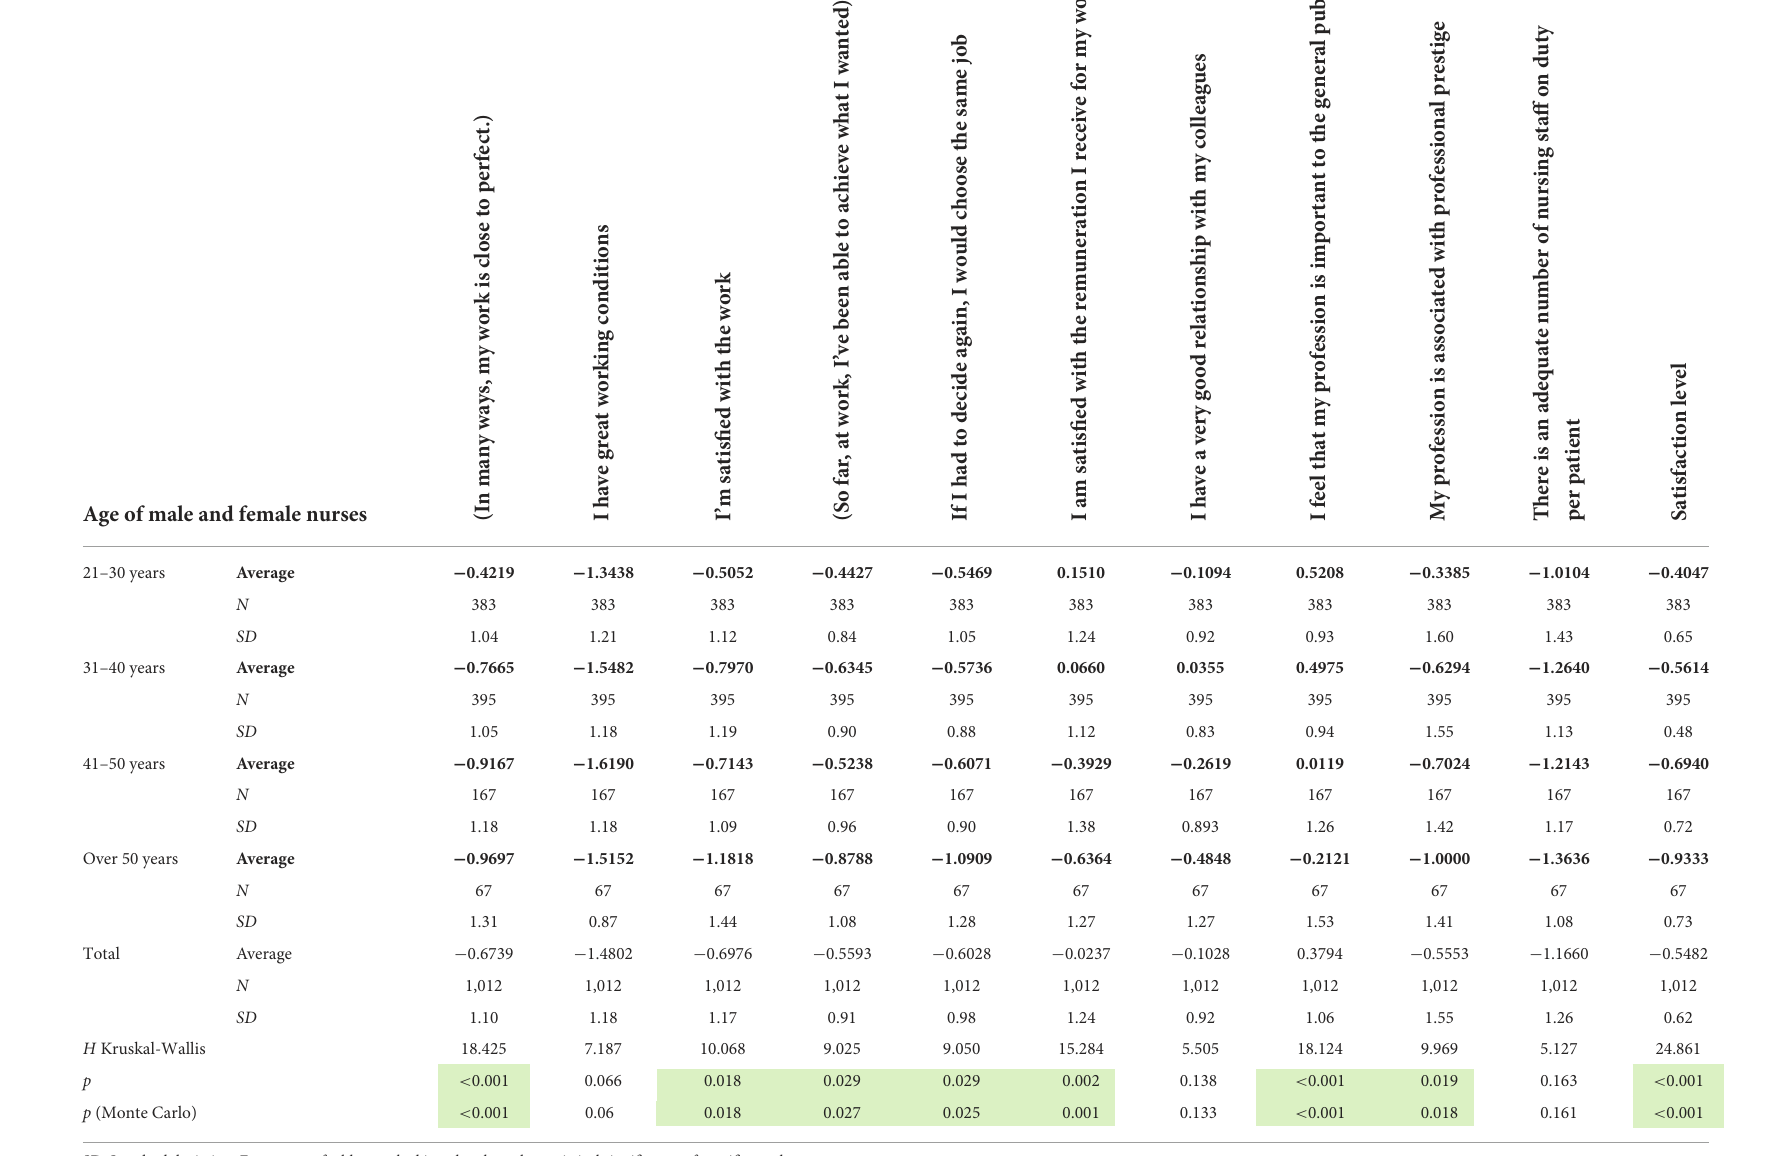
Age of male and female